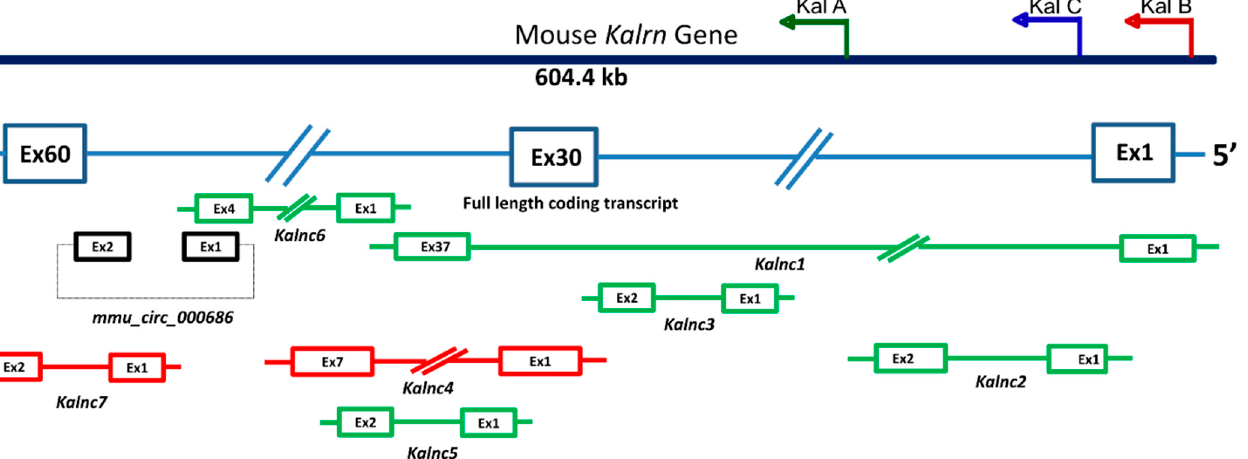
Figure 1. Schematic illustration and coding potential prediction of mouse Kalrn gene locus noncoding transcripts. ( A ) A schematic illustration of mouse Kalrn long noncoding transcripts (lncRNAs) was made according to the Ensembl database; blue: coding transcripts, green: